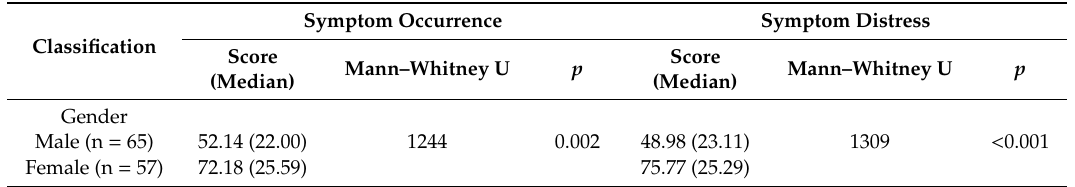
Table 2. Comparison of median symptom occurrence and symptom distress scores among kidney recipients according to gender.